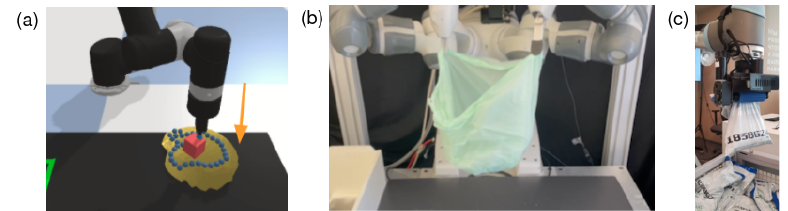
Figure 8. Different bag manipulation tasks: ( a ) Item insertion by Seita et al. (2021a) [34] , ( b ) item containing/sack lifting reproduced by Seita et al. (2021b) [242], and ( c ) sack moving by Gonnochenko et al. (2021) [231]. Figures reproduced with